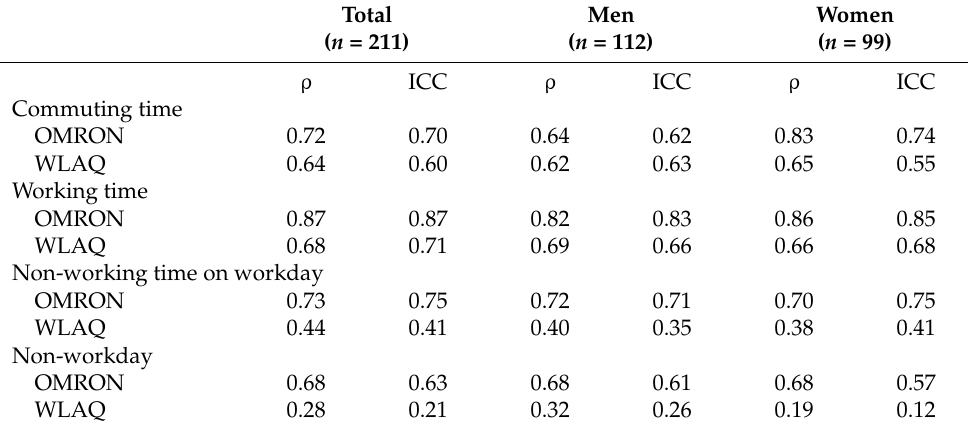
Table 2. Criterion validity of values measured by OMRON and WLAQ compared with activPAL by